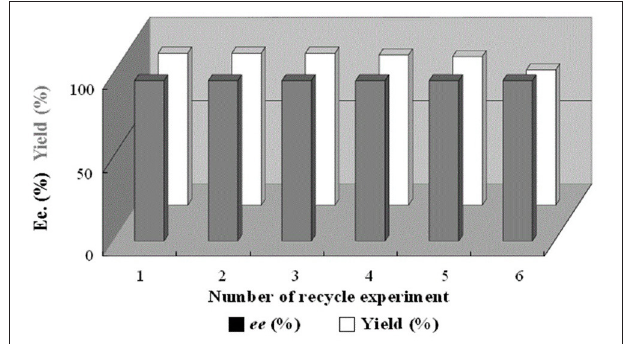
FIGURE 7 | Reusability of catalyst 1 for the organic transformation of 1–phenylprop − 2–enone and aniline to ( S ) − 1–phenyl −